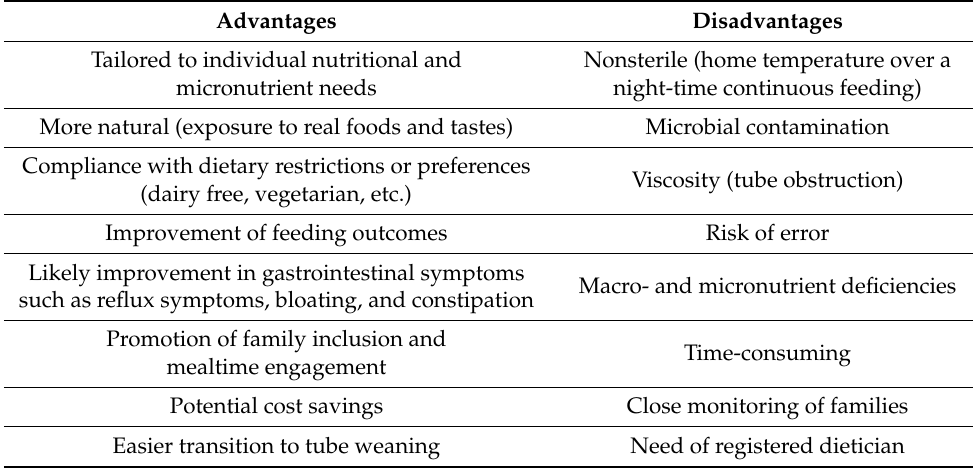
Table 3. Blenderized-tube-feeding advantages and disadvantages [3,24,25]. Advantages Disadvantages Tailored to individual nutritional and Nonsterile (home temperature over a micronutrient needs night-time continuous feeding) More natural (exposure to real foods and tastes) Microbial contamination Compliance with dietary restrictions or preferences (dairy free, vegetarian, etc.) Likely improvement in gastrointestinal symptoms such as reflux symptoms, bloating, and